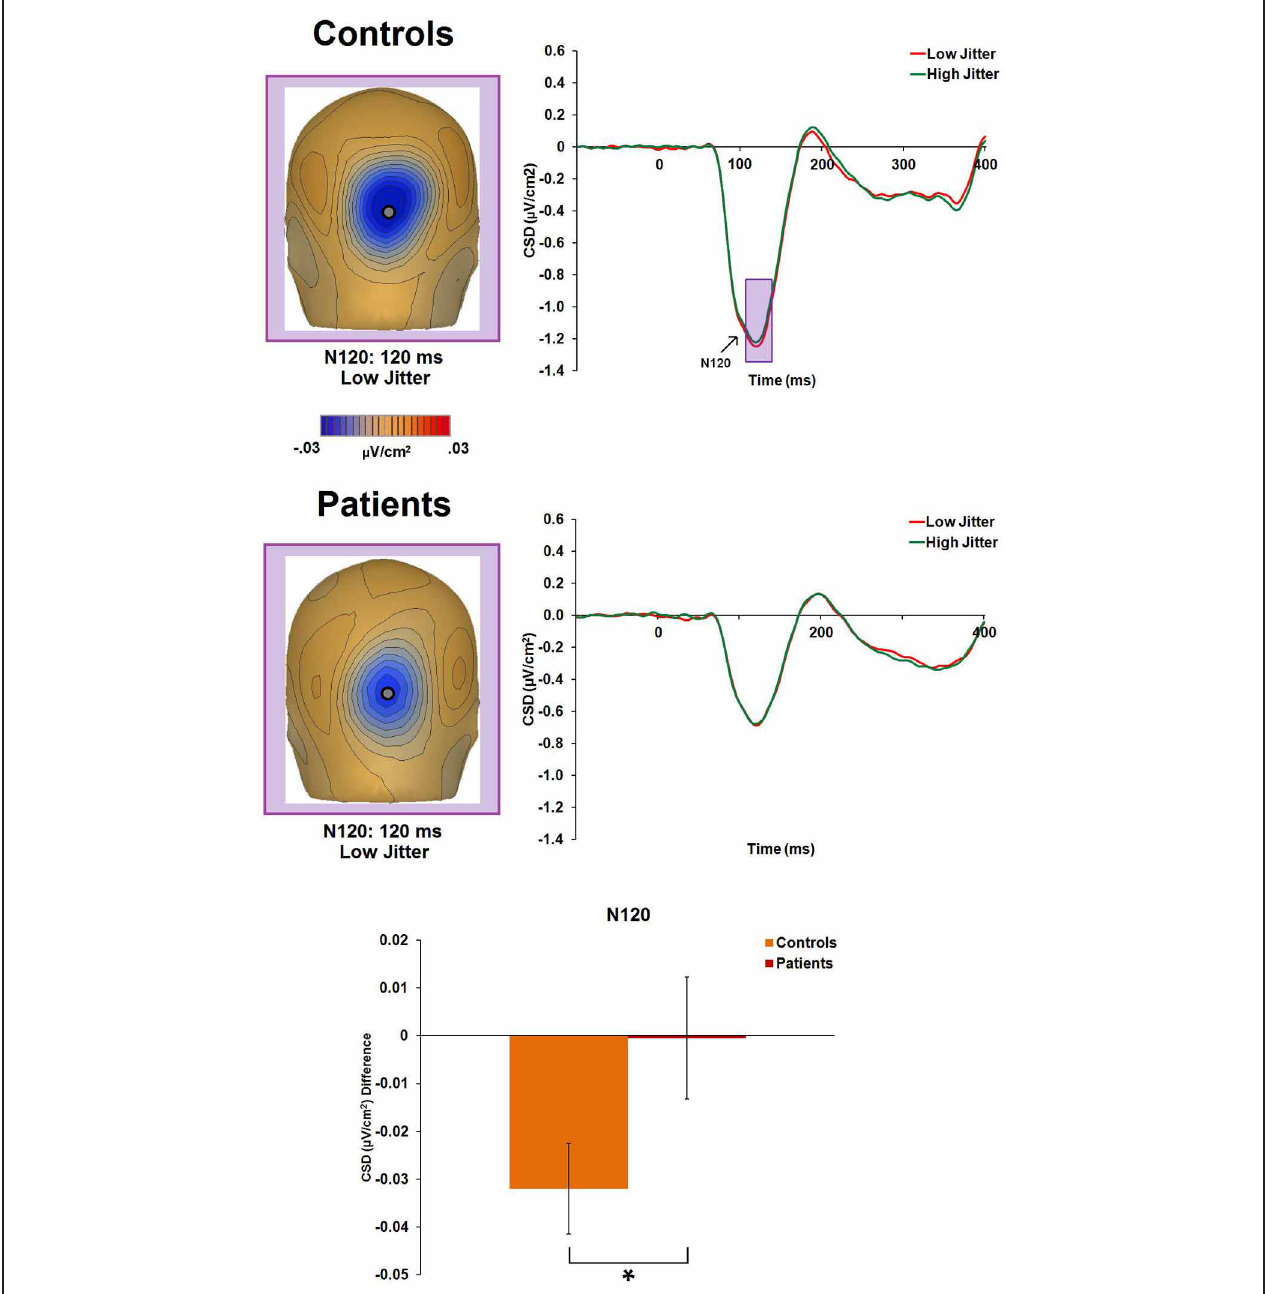
FIGURE 4 | Event-related potential CSD responses to low- and high-jitter stimuli from occipital electrodes (P0z, Oz) in controls and patients for the N120 component. The waveforms indicate small but significant differences between the jitter conditions for controls but not for patients.